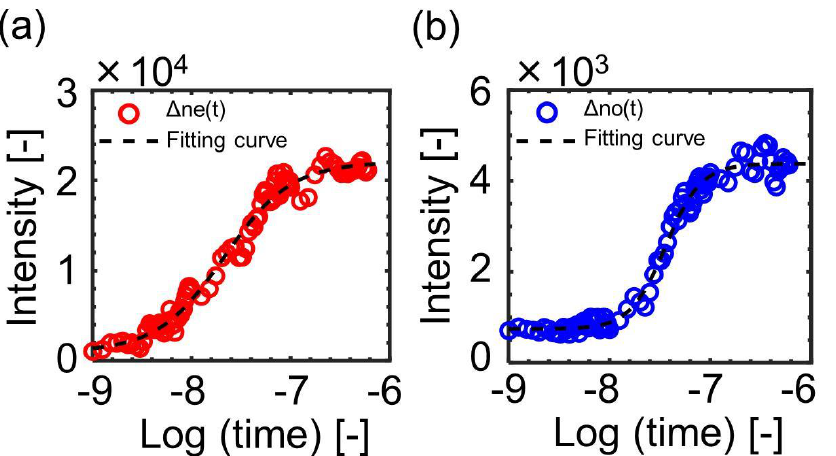
Figure 9. The examples of the fitting curves for the ( a ) ∆ n e ( t ) and ( b ) ∆ n o ( t ) responses by a model function of Equation (3). The data correspond to the responses for 5CB doped with BHAB. The pump intensity was 2.67 mJ/pulse. The fitting parameters were ( a ) y max = 2.09 × 10 4 , y min = 1.38 × 10 3 , log t half = − 7.71, ( b ) y max = 4.23 × 10 3 , y min = 7.62 × 10 2 , log t half = − 7.46 .